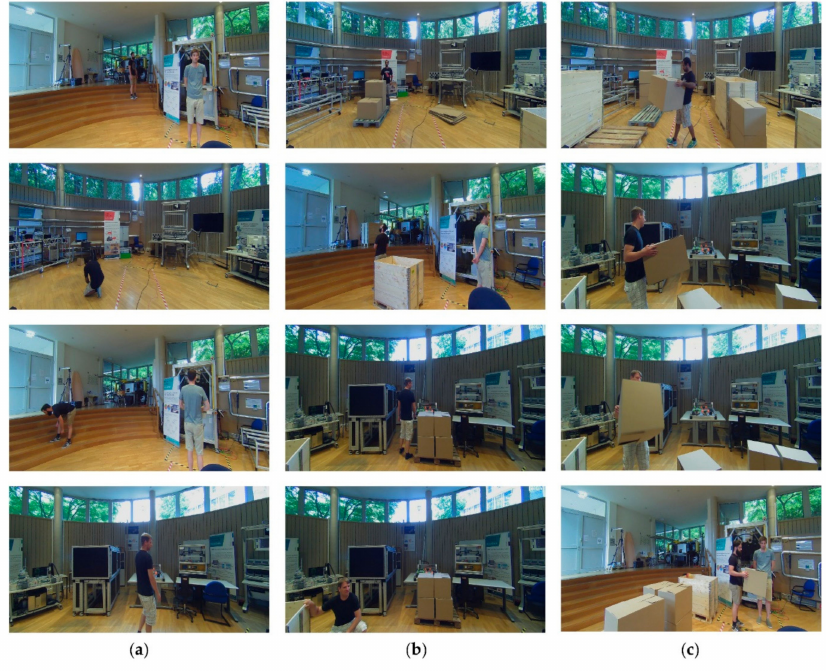
Figure 20. Exemplary dataset subsegments. ( a ) S static ; ( b ) S crowded ; ( c ) S dynamic